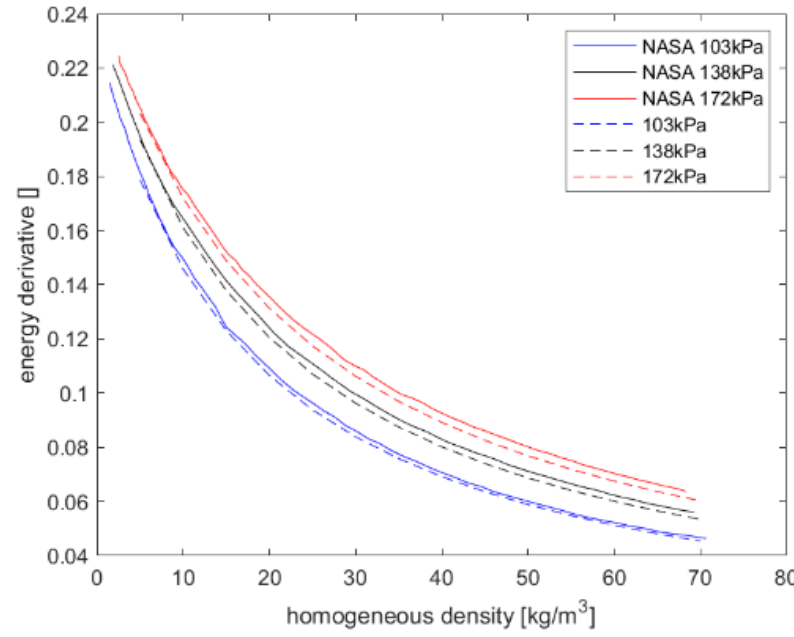
Figure A1. Energy derivative estimation comparison with [31].